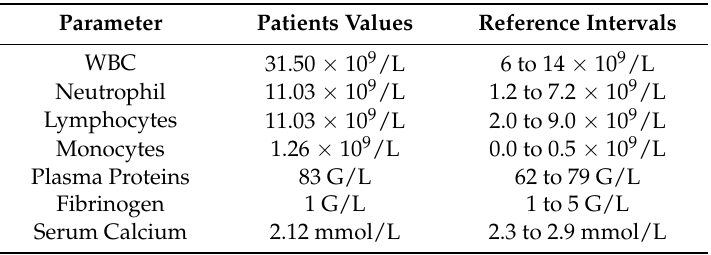
Table 1. Main haematological parameters on admission. Marked leukocytosis, neutrophilia, lymphocytosis, and mild monocytosis, with a mildly elevated total protein, were